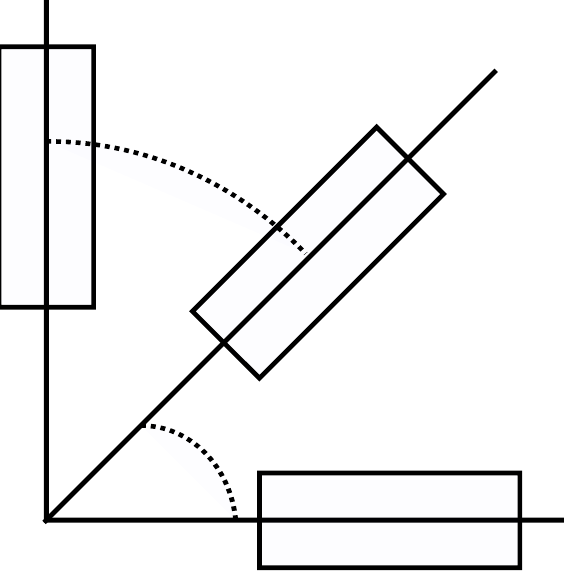
Figure 10. Definition of a strain gauge